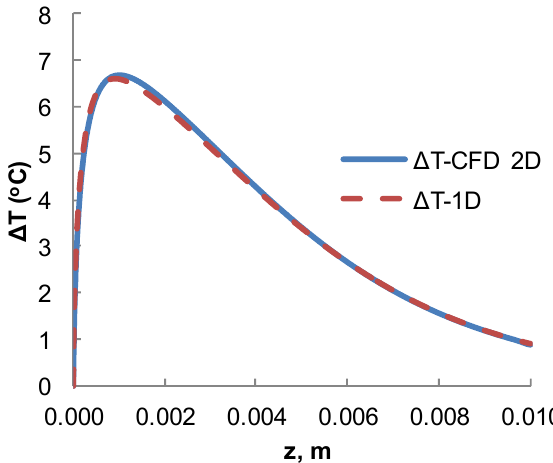
Figure 8. Profiles of the temperature difference between the surface and bulk gas derived from the non-isothermal 2-D CFD model vs the profiles derived from the non-isothermal 1-D model combined with the 1-D correlations for heat and mass transfer. Rich gas feed composition. Inlet temperature 400 °C. Inlet velocity 1.1 m/s. Re = 19.1.